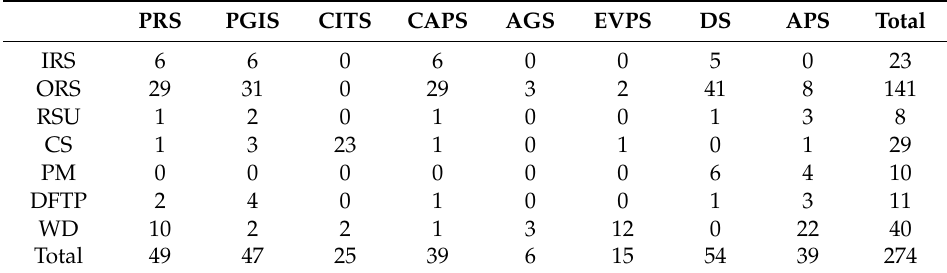
Table 11. Relationship between the type of VDT (rows) and type of SPS